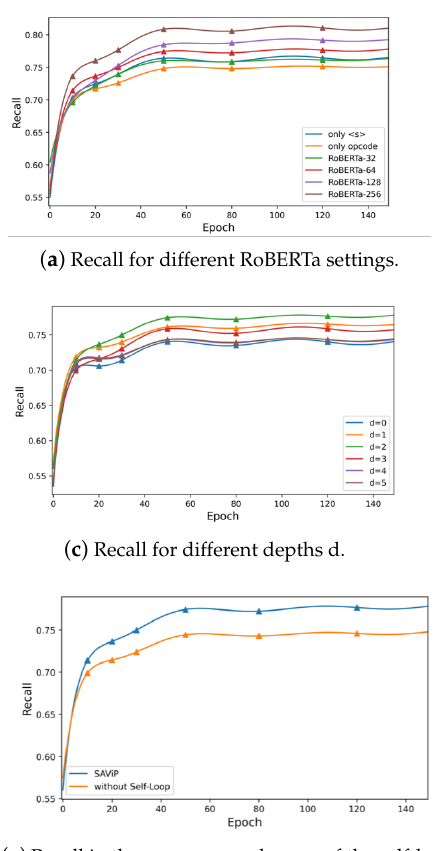
Figure 10. Results for different training